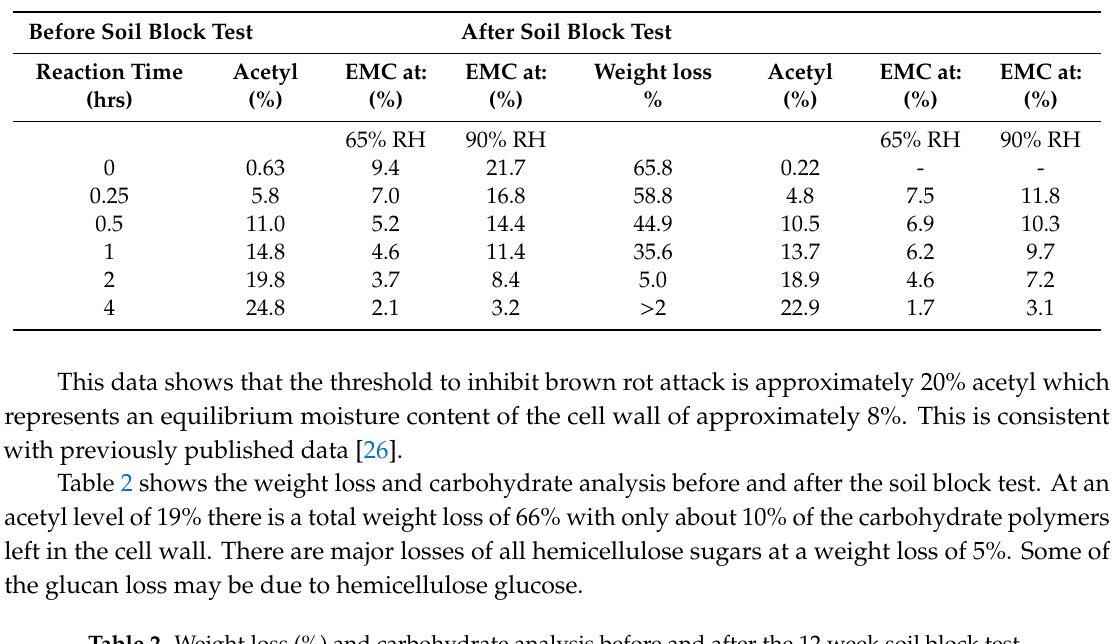
Table 2. Weight loss (%) and carbohydrate analysis before and after the 12 week soil block test.